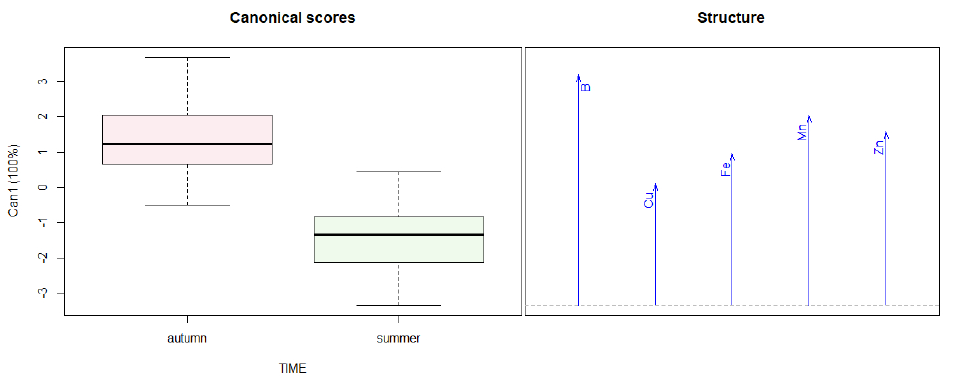
Figure 4. Discriminant canonical analysis on micronutrient content ( µ g cm − 2 ) in summer and autumn leaves. Data from both cultivars were included. Bar charts ( left ) of discriminant functions and arrows ( right ) represent the direction of each parameter analysed.